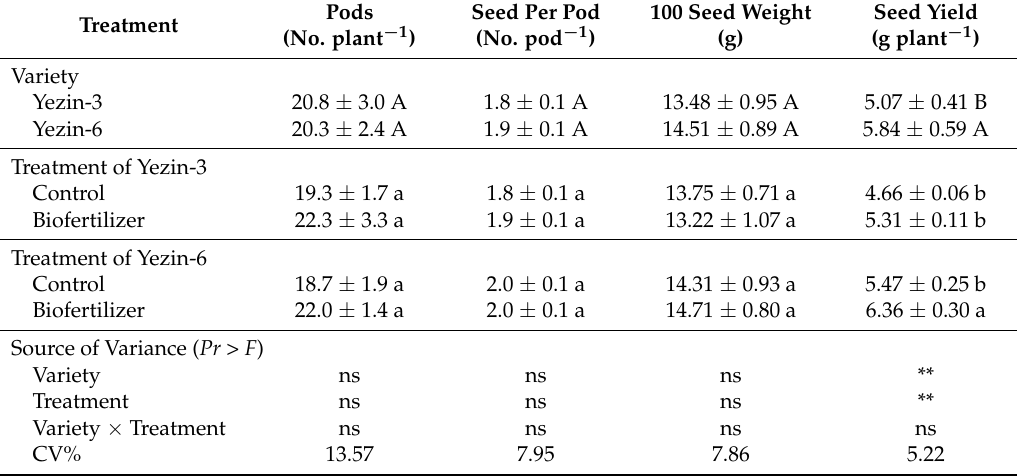
Table 9. Effect of biofertilizer on yield and yield related parameters of Yezin-3 and Yezin-6 soybean varieties at R8